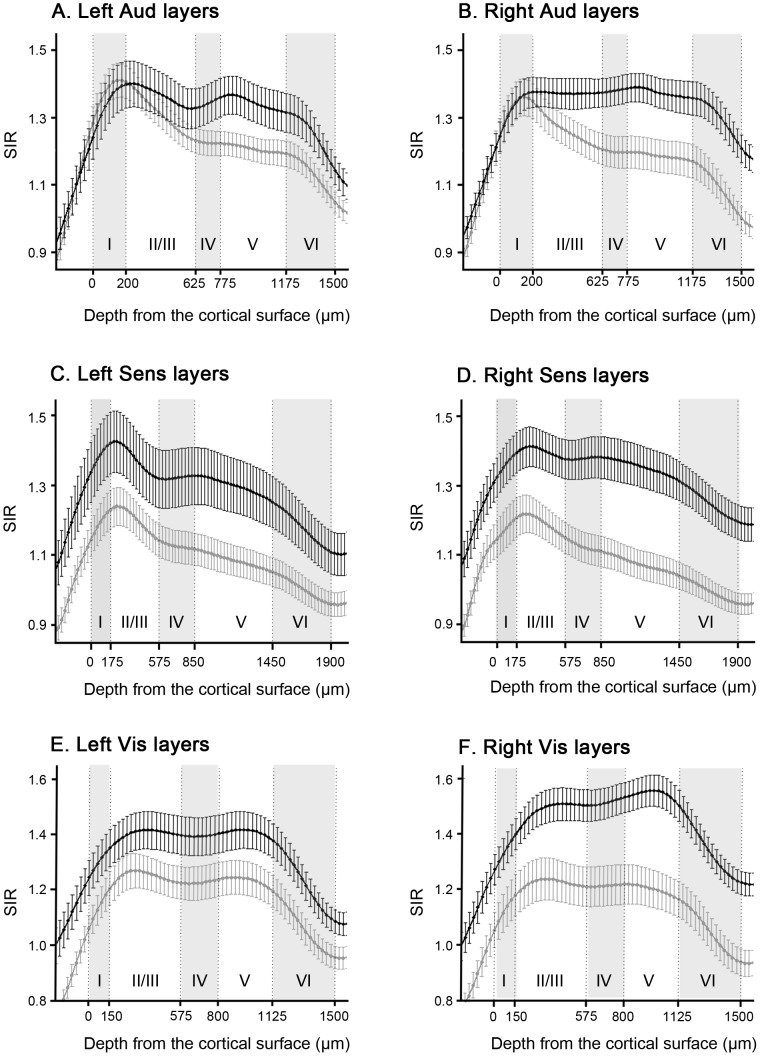
Profiles of signal intensity ratio (SIR) as a function of depth from the surface of cortices.(A) Left Aud layers (B) Right Aud layers (C) Left Sens layers (D) Right Sens layers (E) Left Vis layers (F) Right Vis layers. Black lines and bars indicate the SIRs of the rats with acoustic stimulation; gray lines and bars indicate those without stimulation. Error bars represent the standard error of the mean.